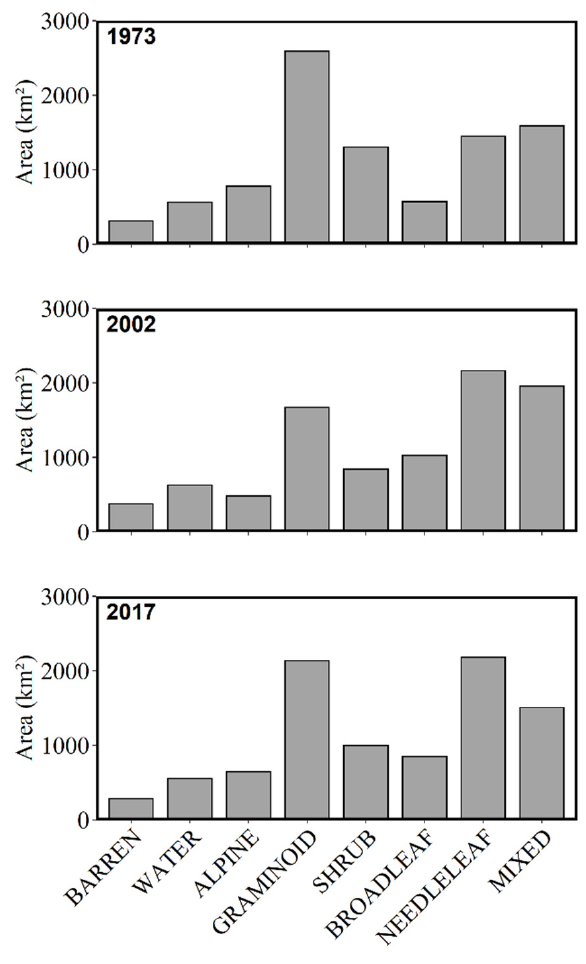
Figure 2. Estimated area of land-cover type by era.